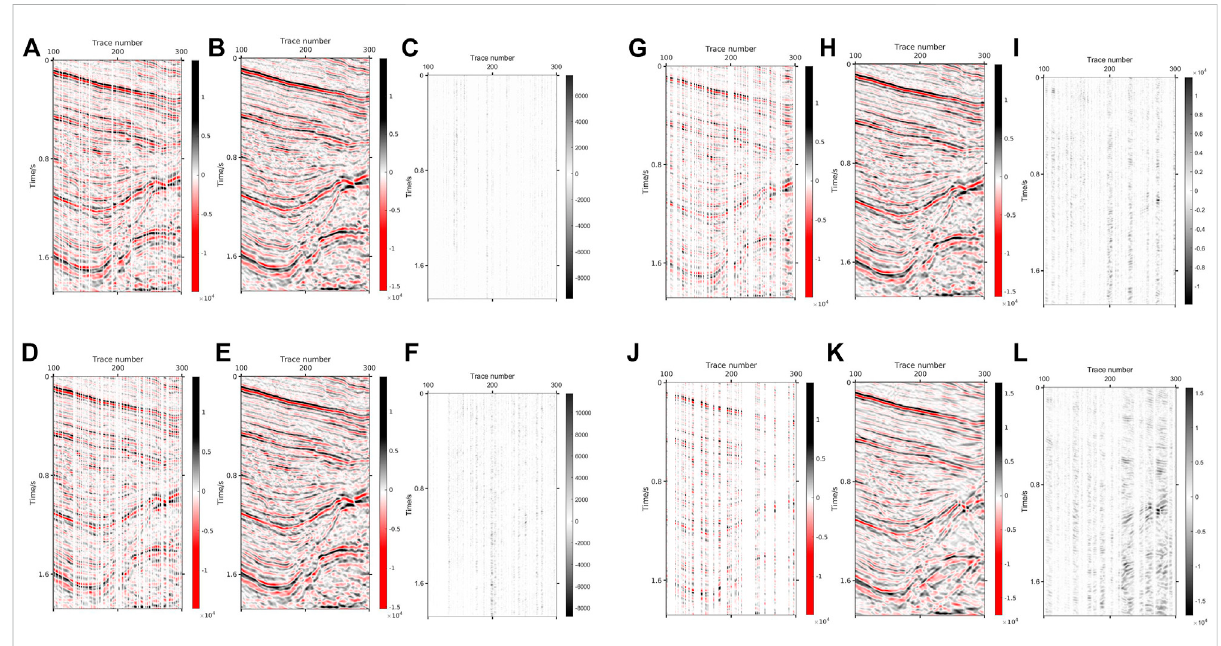
FIGURE 12 DCT+K-SVD results via missing in different proportions. (A) 20% missing image. (B) Reconstructed result via 20% missing (SNR=18.37 dB PSNR=34.72 dB). (C) Absolute error via 20% missing; (D) 40% missing image. (E) Reconstructed result via 40% missing (SNR=14.25 dB PSNR=30.59 dB). (F) Absolute error via 40% missing. (G) 60% missing image. (H) Reconstructed result via 60% missing (SNR=9.83 dB PSNR=26.17 dB). (I) Absolute error via 60% missing; (J) 80% missing image. (K) Reconstructed result via 80% missing (SNR=0.5 dB PSNR=21.29 dB). (L) Absolute error via 80%